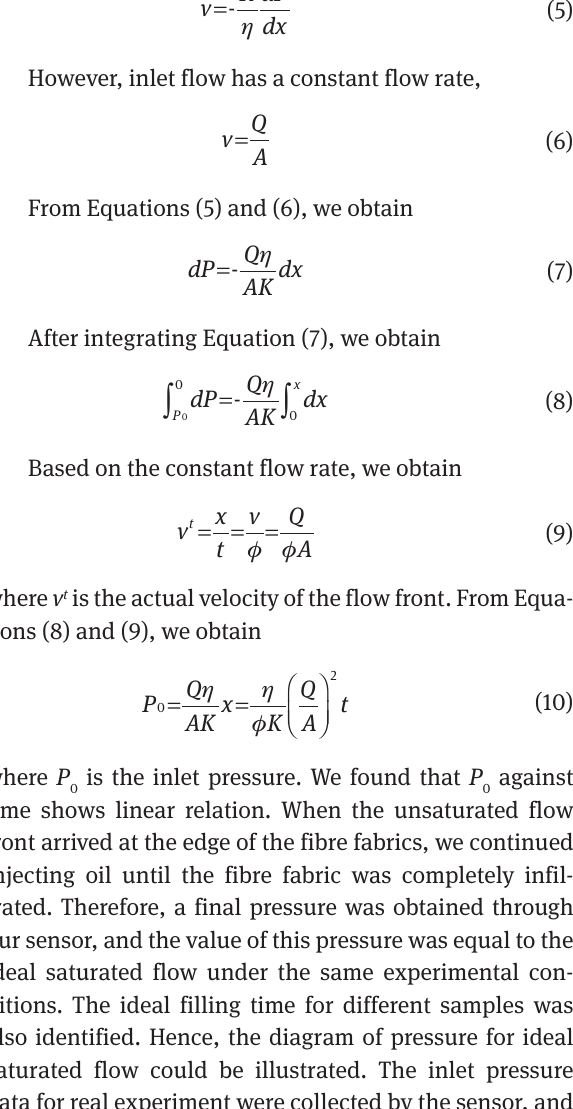
Table 1: Experimental samples and parameters.